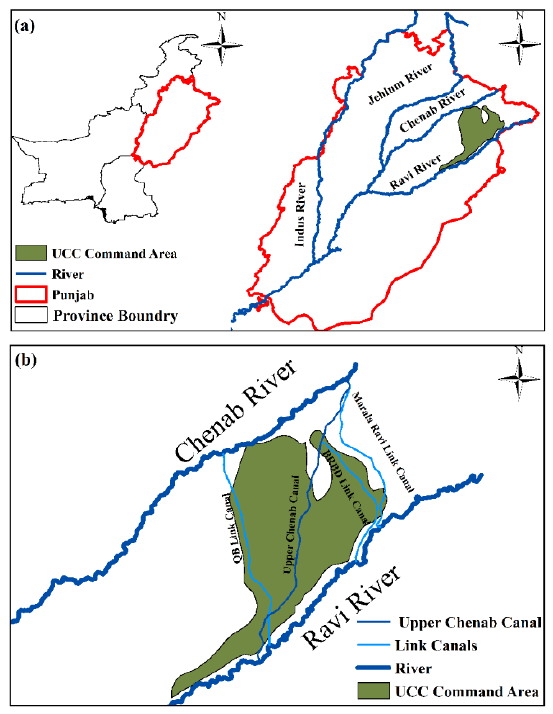
Figure 1. ( a ) Location of the UCC command area in Punjab, Pakistan. ( b ) Major water channels in the UCC command area.